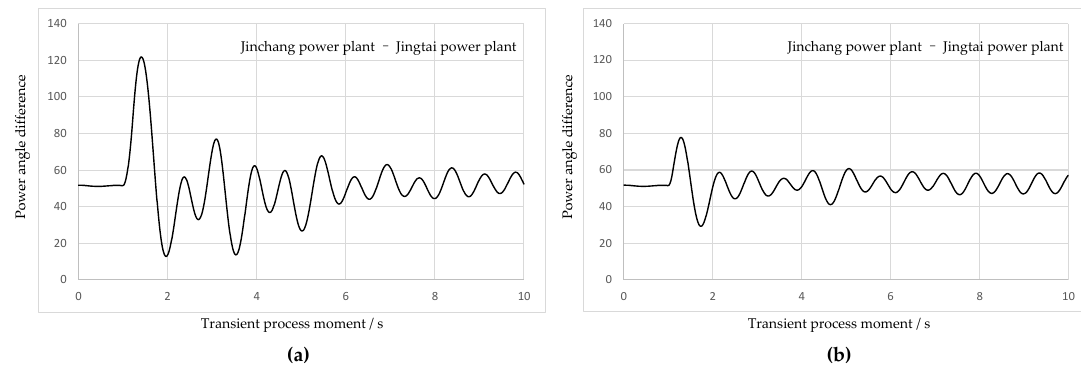
Figure 6. System transient stability of Wusheng substation: ( a ) before reactive power adjustment and ( b ) after reactive power adjustment.